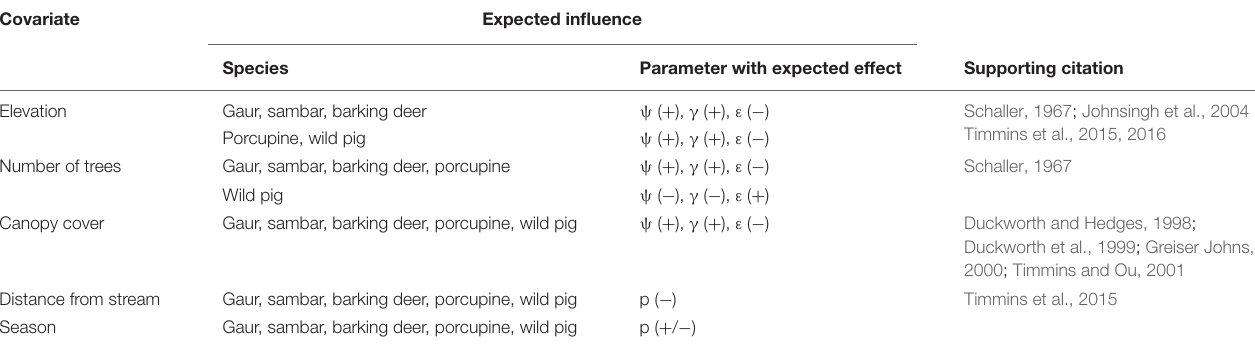
TABLE 2 | Description of covariates with a priori hypotheses along riparian forests. Covariate